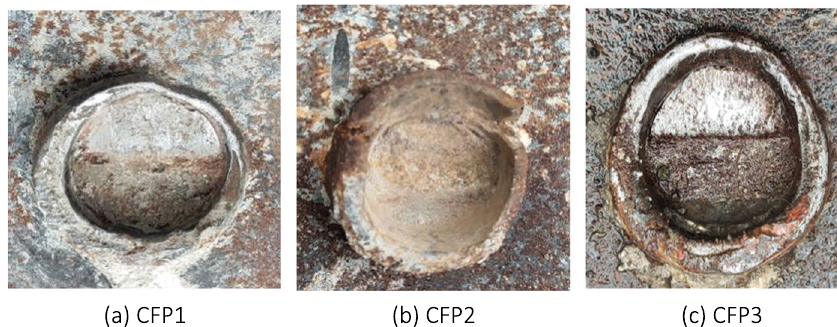
Fig. 9 Cross-section of the failed stud connector (steel plate side)